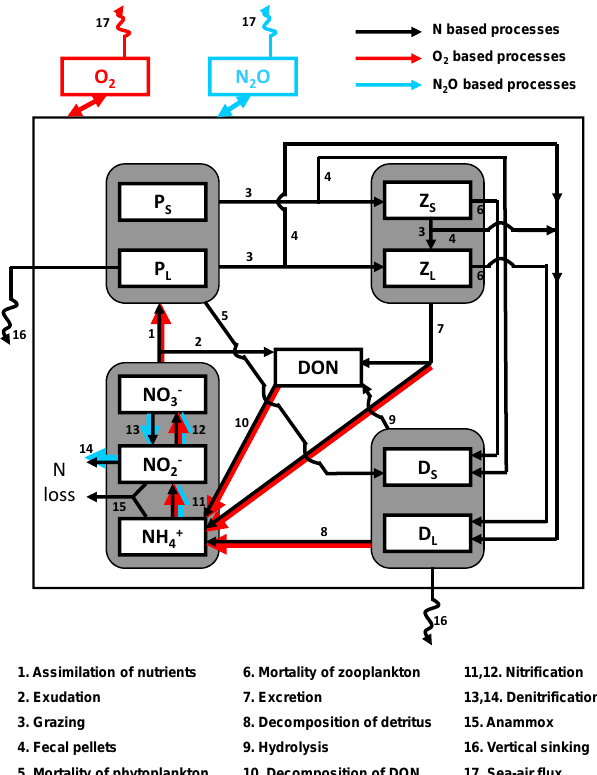
Fig. 2. Interactions between the different compartments of the BioEBUS model. Black arrows represent the nitrogen-dependent processes; red arrows, the oxygen-dependent processes; blue ar- rows, the processes linked with N 2 O production. To simplify the representation of all interactions between variables, arrows from or to a grey rectangle act on all variables included in this grey rect- angle. For example, the arrow between nutrients and phytoplankton (assimilation) is a simplification of 6 interactions: NO − to P S , NO − 3 3 to P L , NO − to P S , NO − to P L , NH + to P S , NH + to P L 2 2 4 4